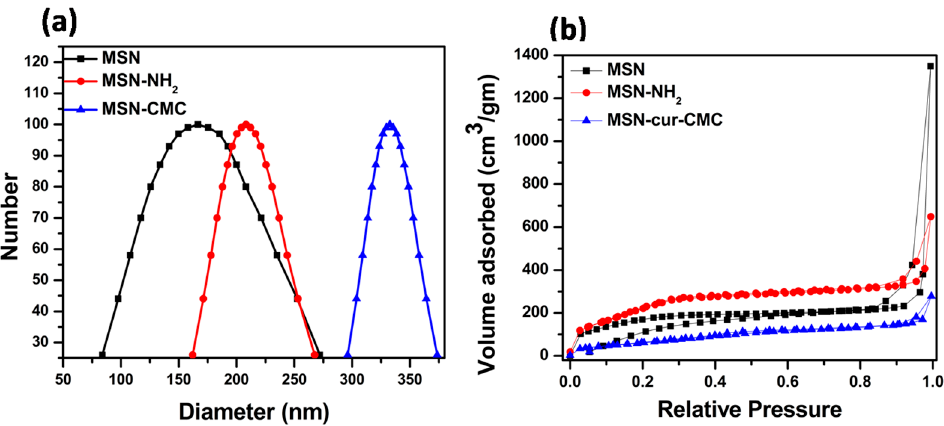
Figure 2. ( a ) Particle size distribution of MSN and functionalized MSNs obtained by DLS experiments and ( b ) nitrogen adsorption-desorption isotherms of MSN, MSN-NH 2 and MSN-cur-CMC nanoparticles. Table 1. Physical properties of various MSNs.